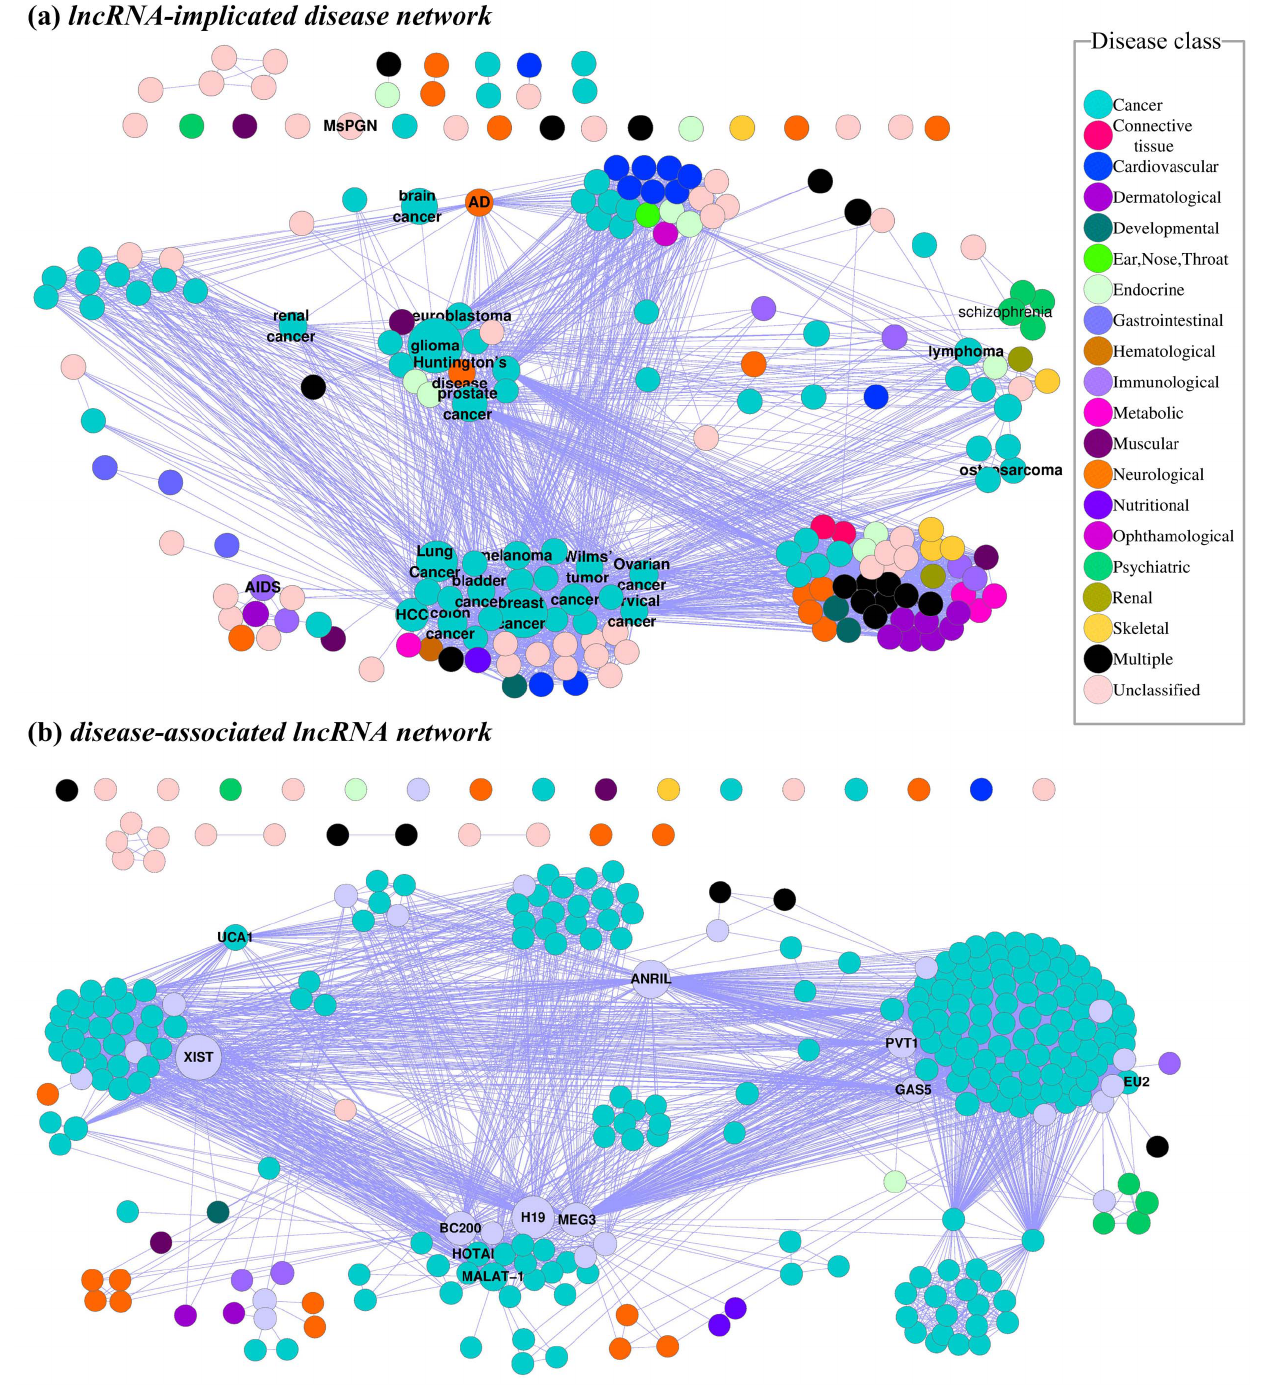
Figure 2. The lncDN and DlncN. (a) In lncDN, each node corresponds to a distinct disease, colored based on the disease class [26] to which it belongs. The names of 20 disease classes are shown on the right panel. A link between two diseases exists if they share at least one implicated lncRNA. The size of the node is proportional to the degree of the node in lncRNA-disease association network. We label the diseases associated with more than five lncRNAs by their names. (b) In DlncN, each node is a lncRNA, with two lncRNAs being connected if they are implicated in the same disease. The size of each node is proportional to the number of diseases in which the lncRNA is implicated. The color of a node is based on the class of diseases in which the corresponding lncRNA implicated. Nodes are light purple if the corresponding lncRNAs are associated with more than one disease class. We label the lncRNAs implicated in more than five diseases by their names.